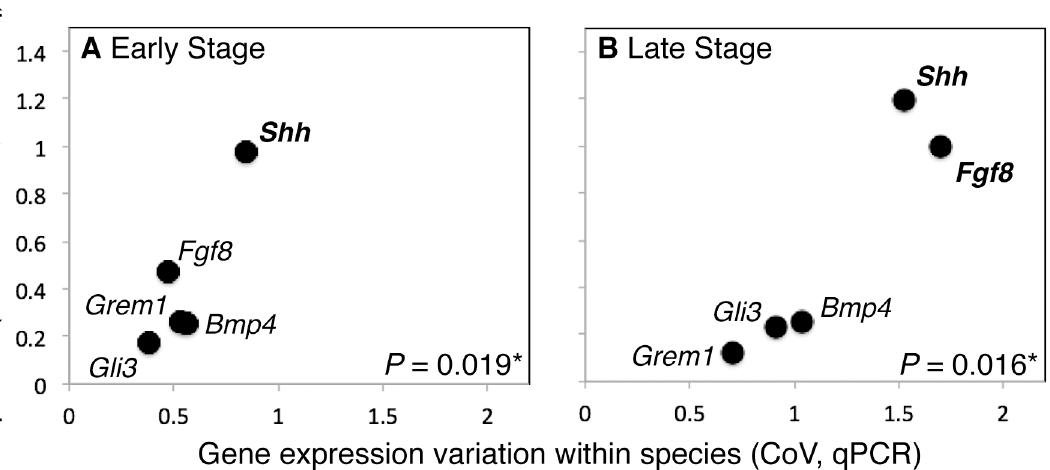
Fig 5. Variation in gene expression levels within a population of mice and among mammalian species are positively correlated during the Early (ES; A) and Late (LS; B) stages of limb development. Shh also displays the most variation in gene expression levels within and among species in both the ES and